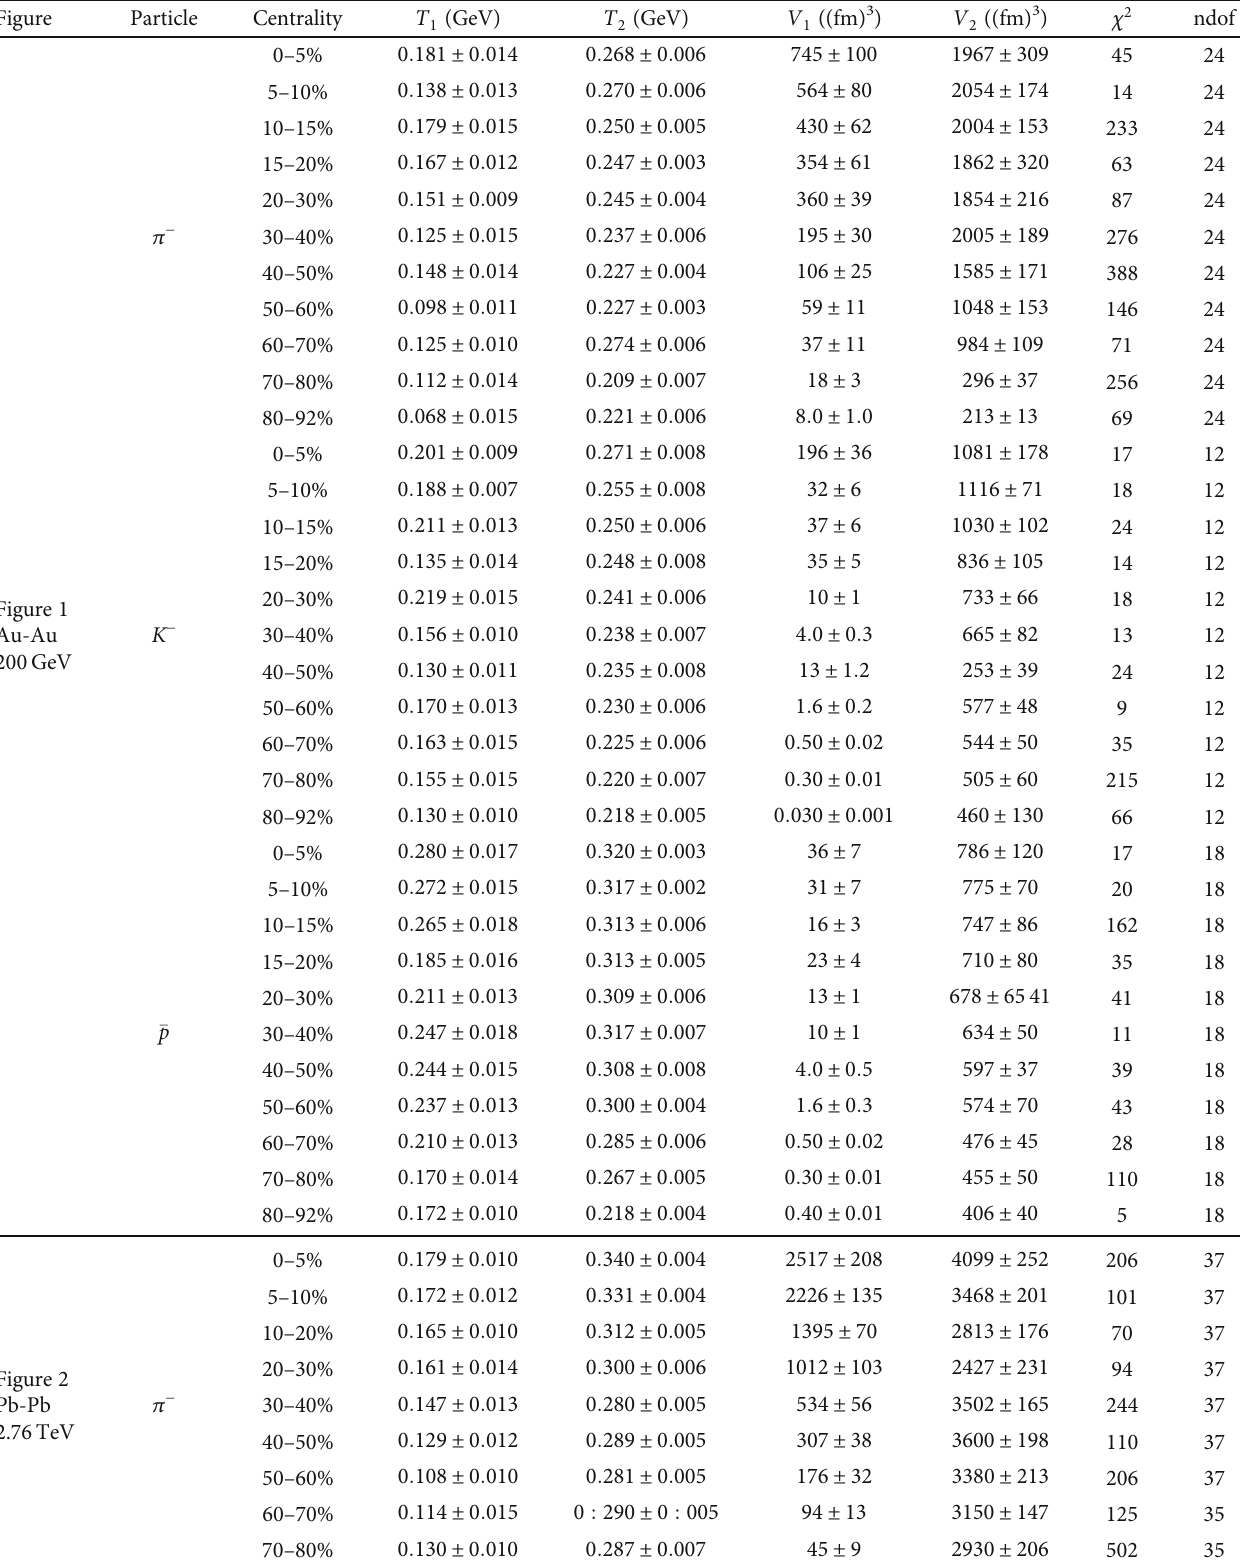
Table 1: Values of e ff ective temperatures ( T the curves in Figures 1 and 2. Figure